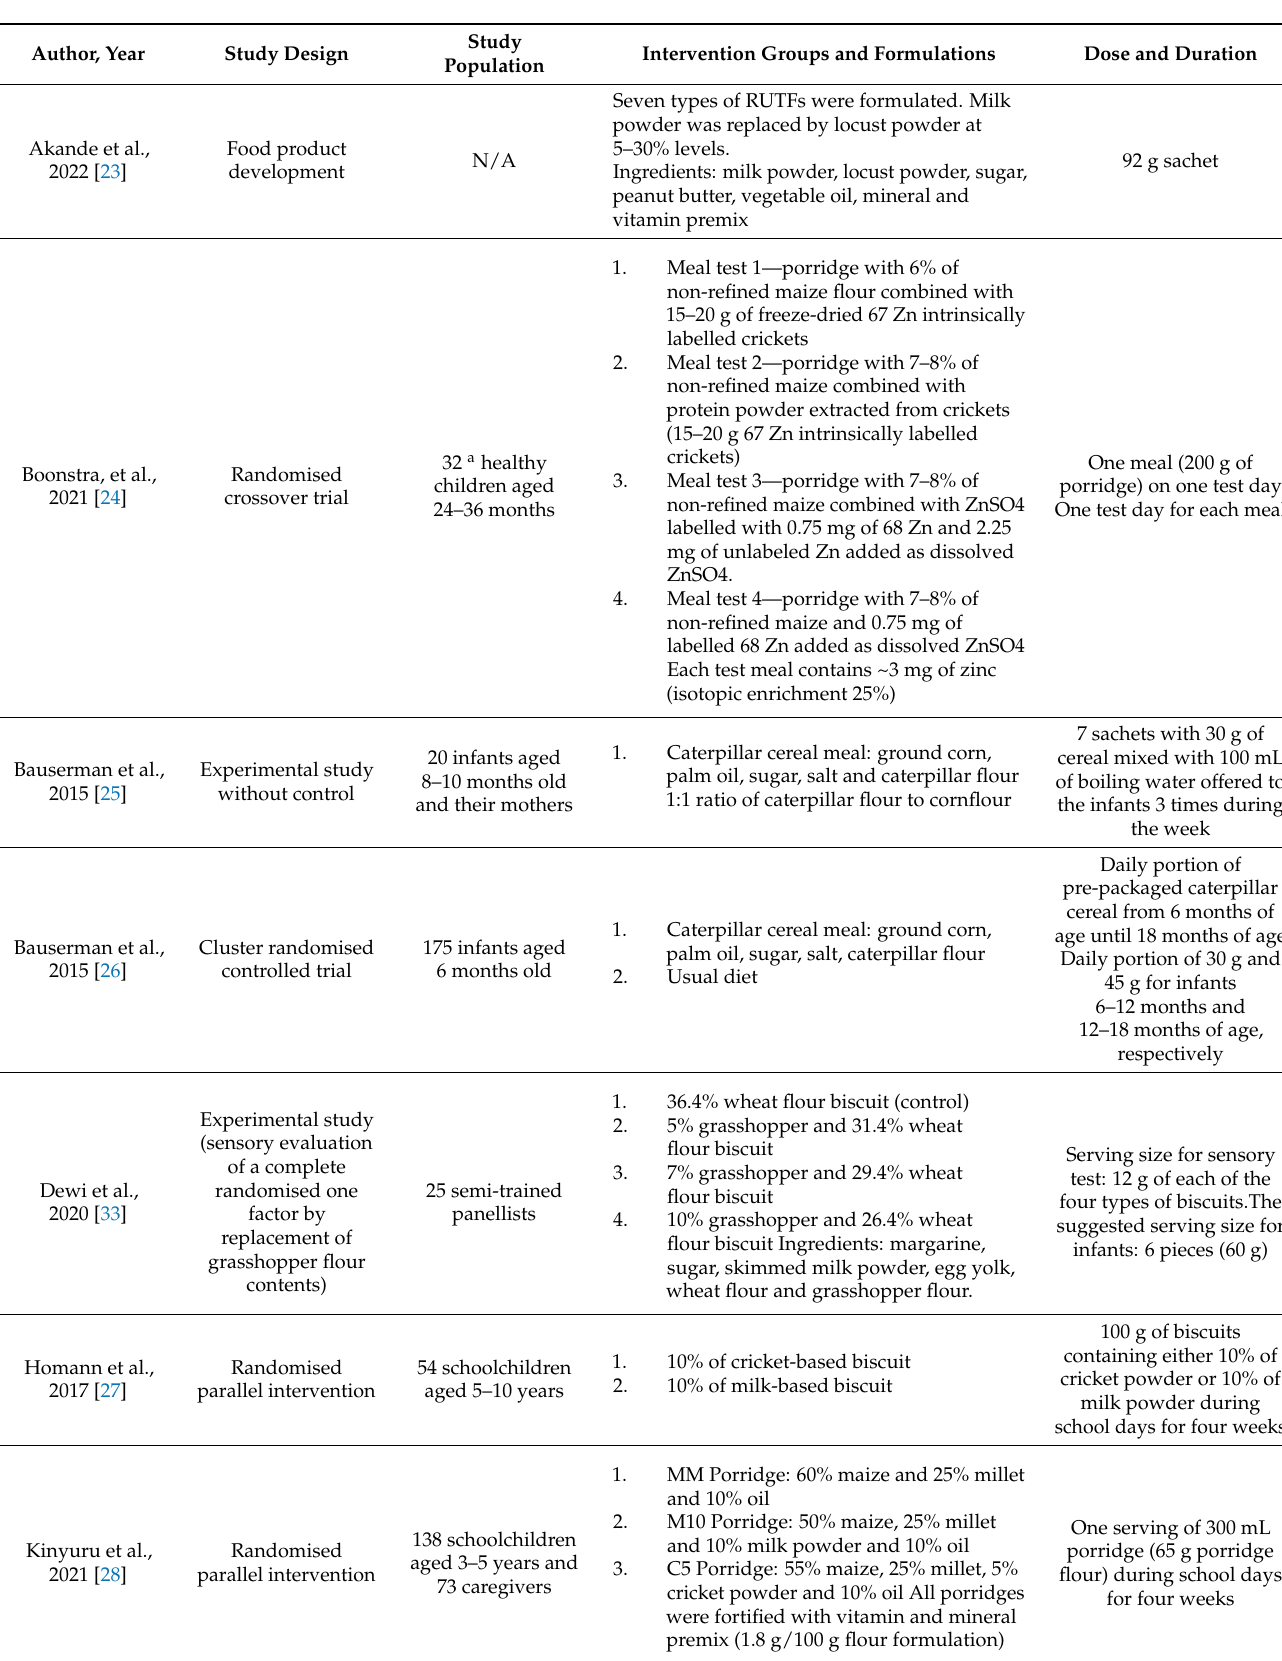
Table 2. Description of study design, intervention groups, and